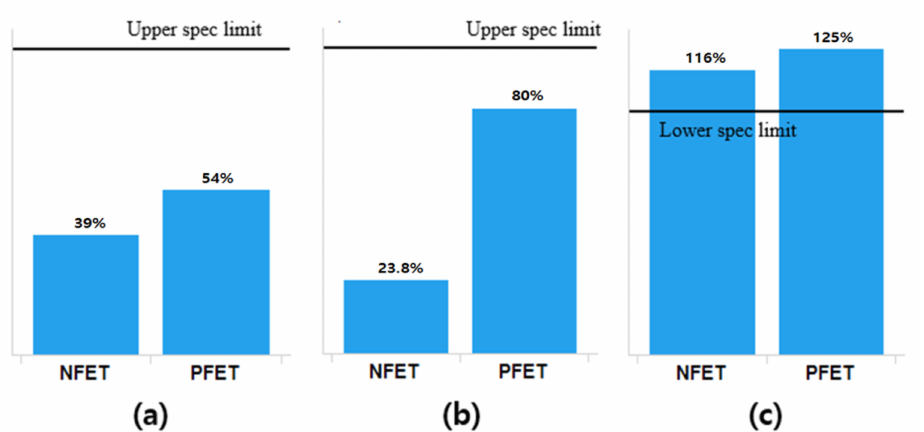
Figure 3. Reliability test result: ( a ) hot-carrier injection (HCI), ( b ) bias temperature instability (BTI), and ( c ) time-dependent dielectric breakdown (TDDB).